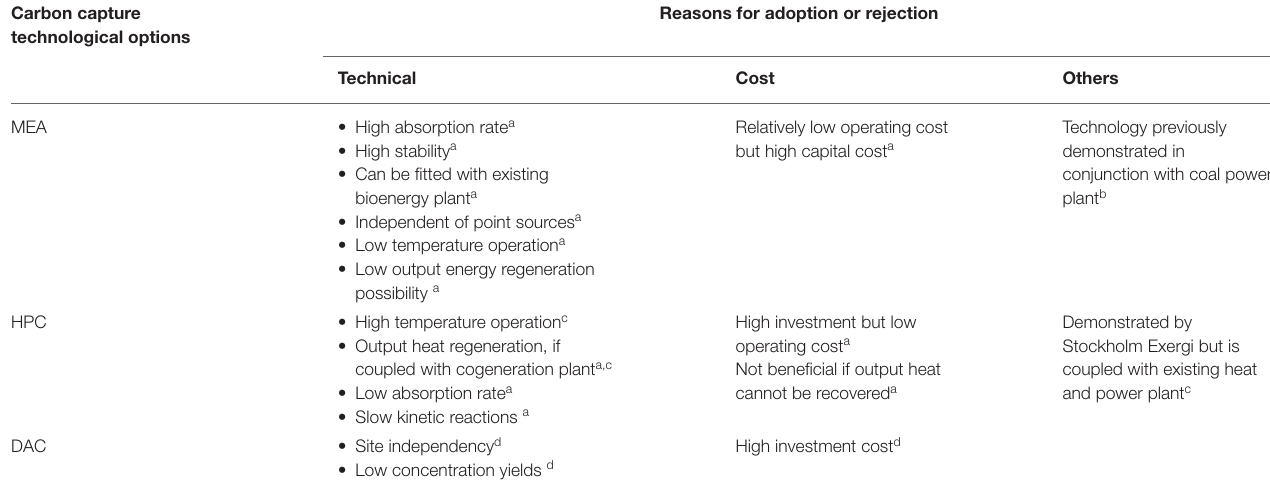
TABLE 2 | Technological limitations/performance, cost, and development of other sectors that affect the selection of carbon capture technology. Carbon capture technological